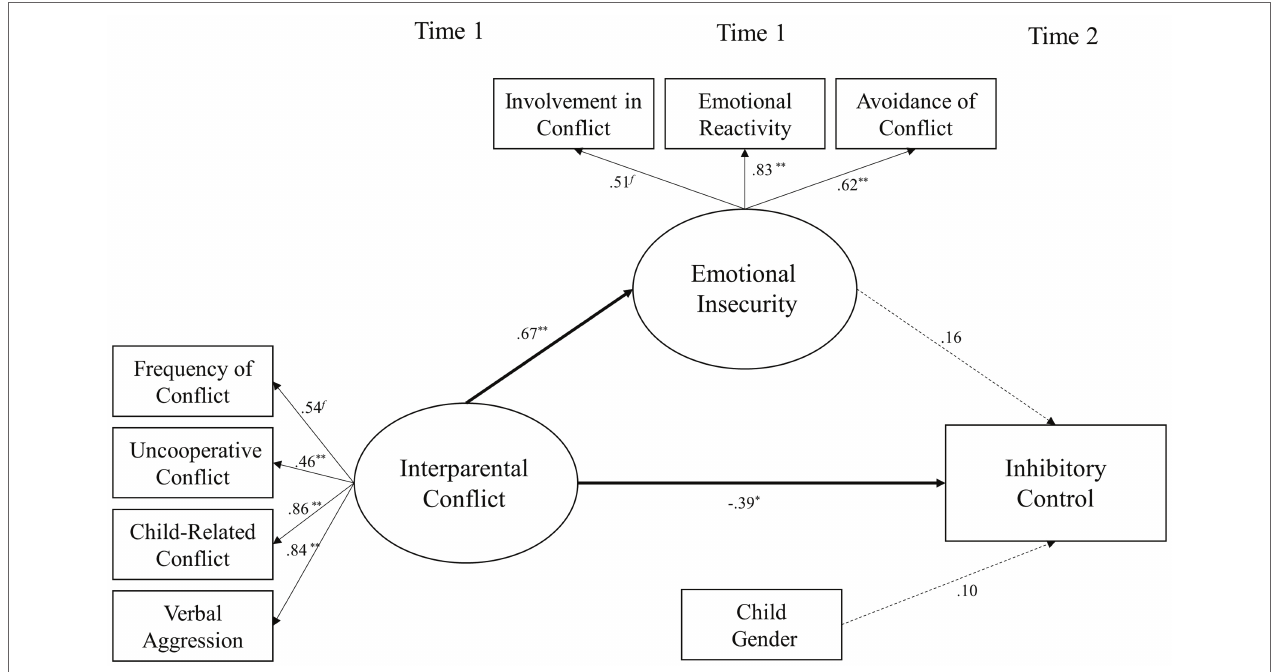
FIGURE 1 | A structural equation model examining emotional insecurity of children as a mediator linking destructive interparental conflict to inhibitory control of children. ∗ p < 0.05 and ∗∗ p <